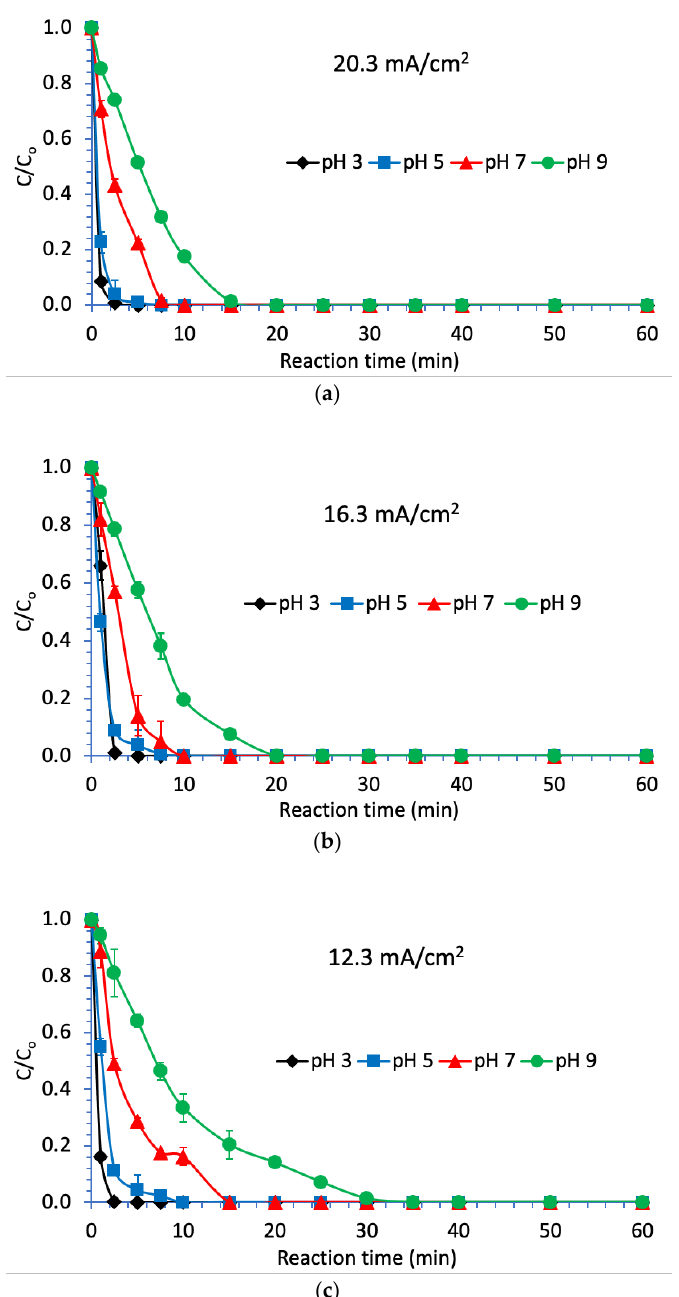
Figure 2. Degradation of naproxen at different current densities and pH values. The figure shows the average of three replicates. ( a ) DC density: 20.3 mA/cm 2 ; ( b ) DC density: 16.3 mA/cm 2 ; ( c ) DC density: 12.3 mA/cm 2 . Table 2. Reaction times (min) for electrochemical oxidation of naproxen in surface water. pH